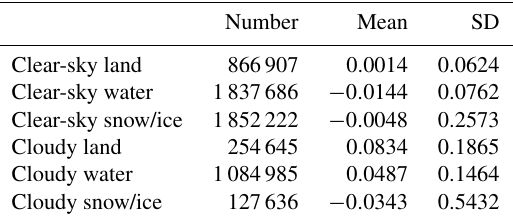
Table 2. Summary of the comparison between TROPOMI GE_LER clear-sky and OMI LER (first three rows) and between TROPOMI GE_LER cloudy and ROCINN_CRB cloud albedo (rows